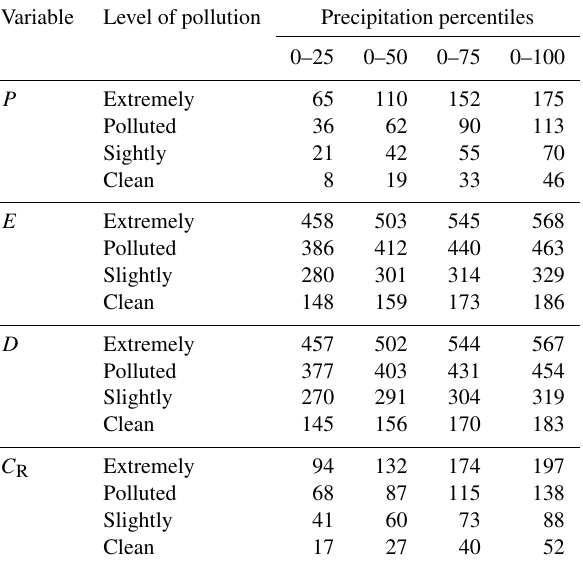
Table 4. Number of days of data ( N ) in each Fig. 4 box plot strati- fied by pollution level (extremely polluted air, polluted air, slightly polluted air, and fairly clean air) and daily precipitation percentiles (columns) from low precipitation (0–25) to all precipitation events (0–100). See “Statistical methods” for